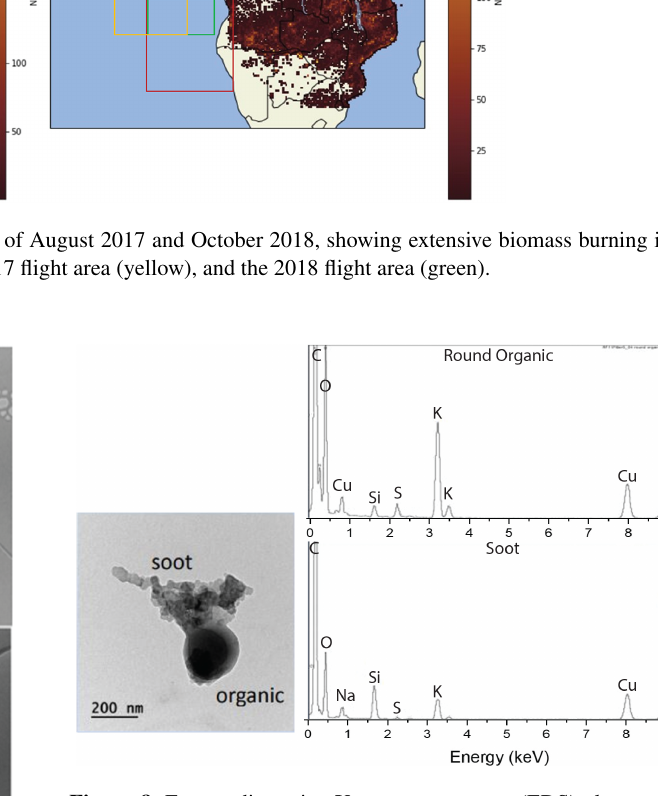
Figure 8. Energy-dispersive X-ray spectroscopy (EDS) elemental analysis of an organic/soot particle from RF 11 on 30 August